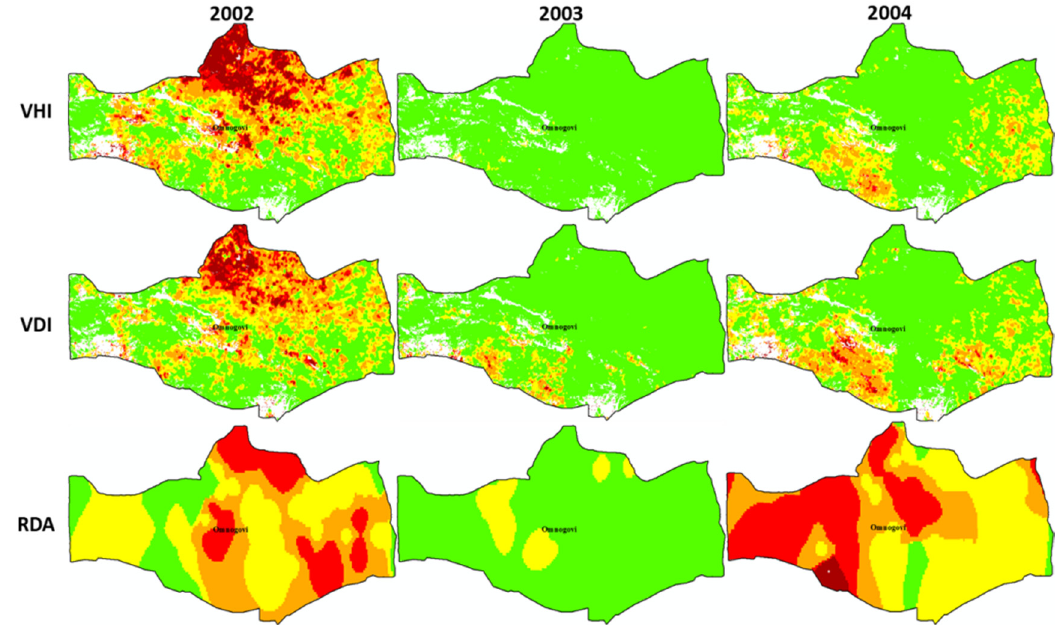
Figure 6. Drought distribution maps of the VHI, VDI, and field-based RDA in the first dekad of each July from 2002 to 2004 for Omnogovi Province. for Omnogovi